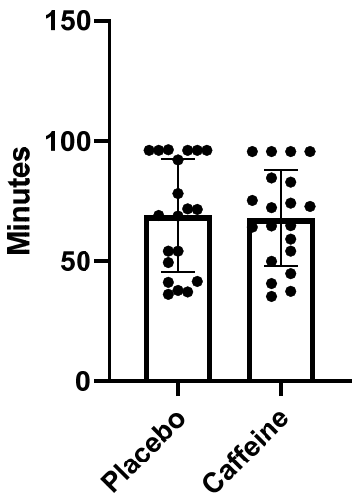
Figure 1. Minutes played: Caffeine vs. Placebo.